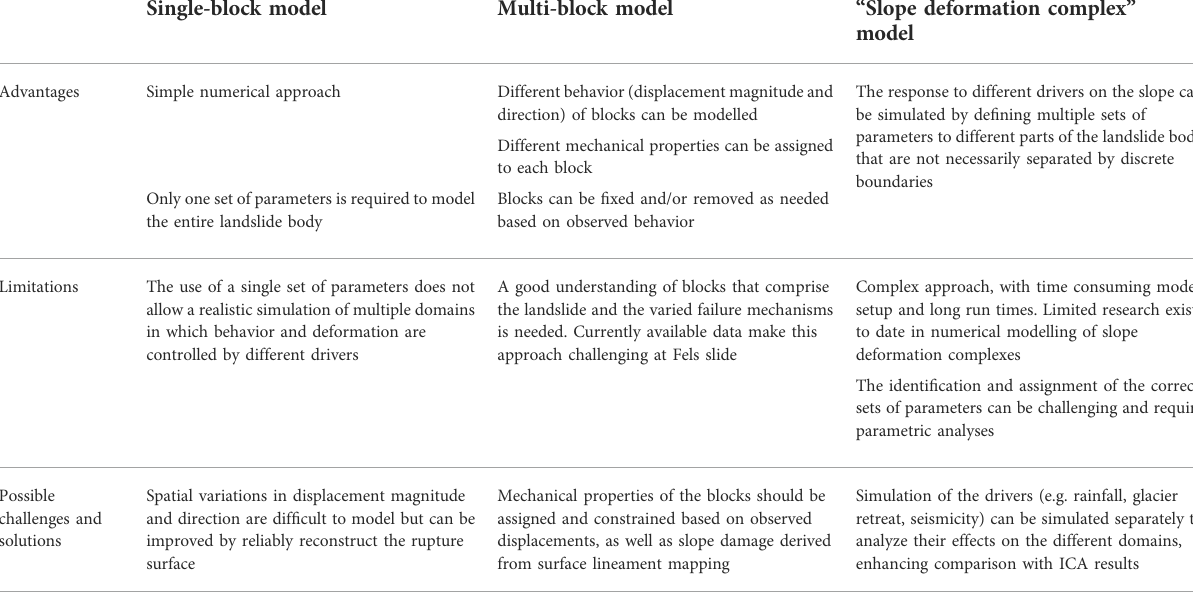
TABLE 3 Overview of the advantages, limitations, challenges, and potential solutions for the numerical modelling of the Fels